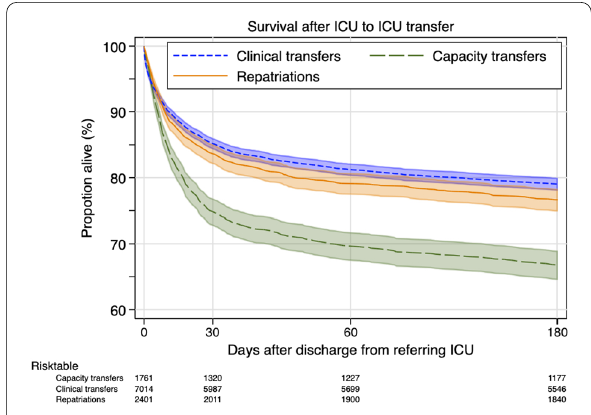
Fig. 2 Kaplan–Meier diagram showing survival after ICU-to-ICU transfer. Shaded area showing 95% CI. Log-rank test p < 0.001